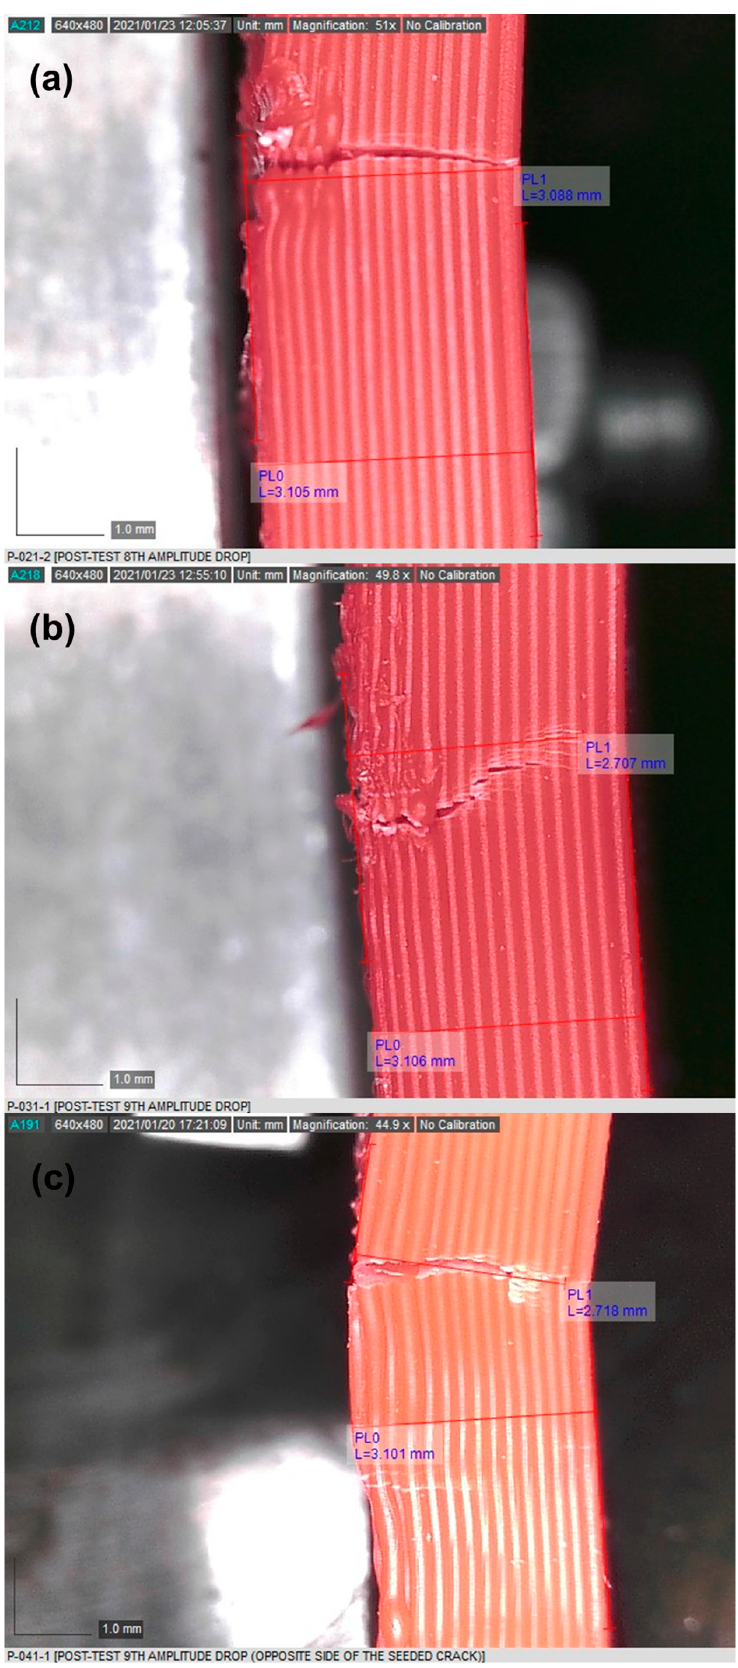
Figure 10. Crack depth of samples at failure: ( a ) 0° cracked, ( b ) 30° cracked, and ( c ) 45° cracked.